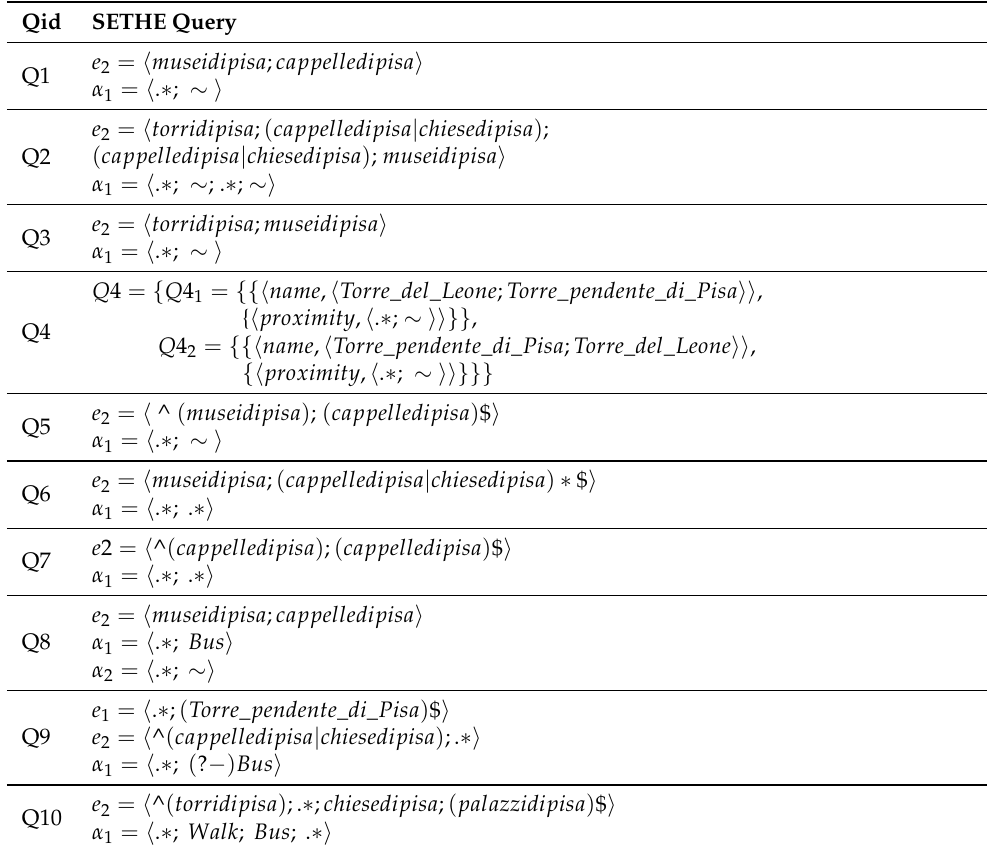
Table 17. Expressing queries using